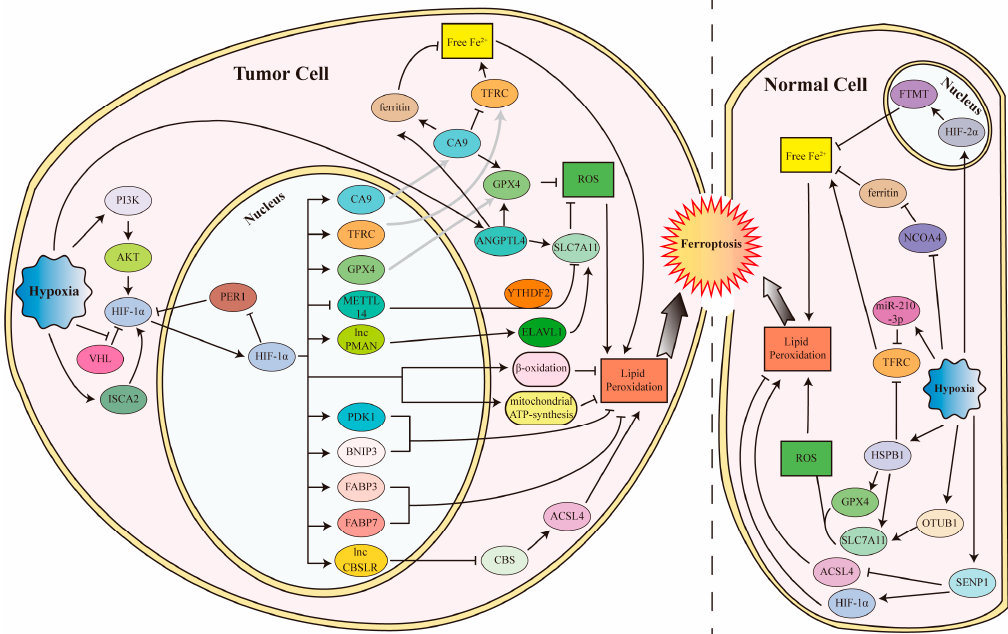
Figure 2. The mechanism of ferroptosis inhibited by hypoxia and HIFs in cells. In tumor cells, hypoxia activates HIF-1 α in both canonical and non-canonical ways, to transcriptionally upregulate the expression of CA9, TFRC, GPX4, METTL14, PDK1, BNIP3, FABP3, FABP7, lncPMAN, and lncCBSLR, as well as increase protein levels of ANGPTL4, ferritin, SLC7A11, and GPX4, and decrease protein levels of TRFC and ACSL4, leading to the reduction in free Fe2+, ROS, and lipid peroxidation, and eventually inhibiting ferroptosis. In normal cells, hypoxia induces HIF-2 α , HIF-1 α , SENP1, OTUB1, HSPB1, and miR-210-3p, and represses NCOA4, to regulate FTMT, ferritin, TRFC, ACSL4, GPX4, SLC7A11, and ultimately inhibits ferroptosis. The gray arrows indicate the protein translation process from their corresponding mRNAs.